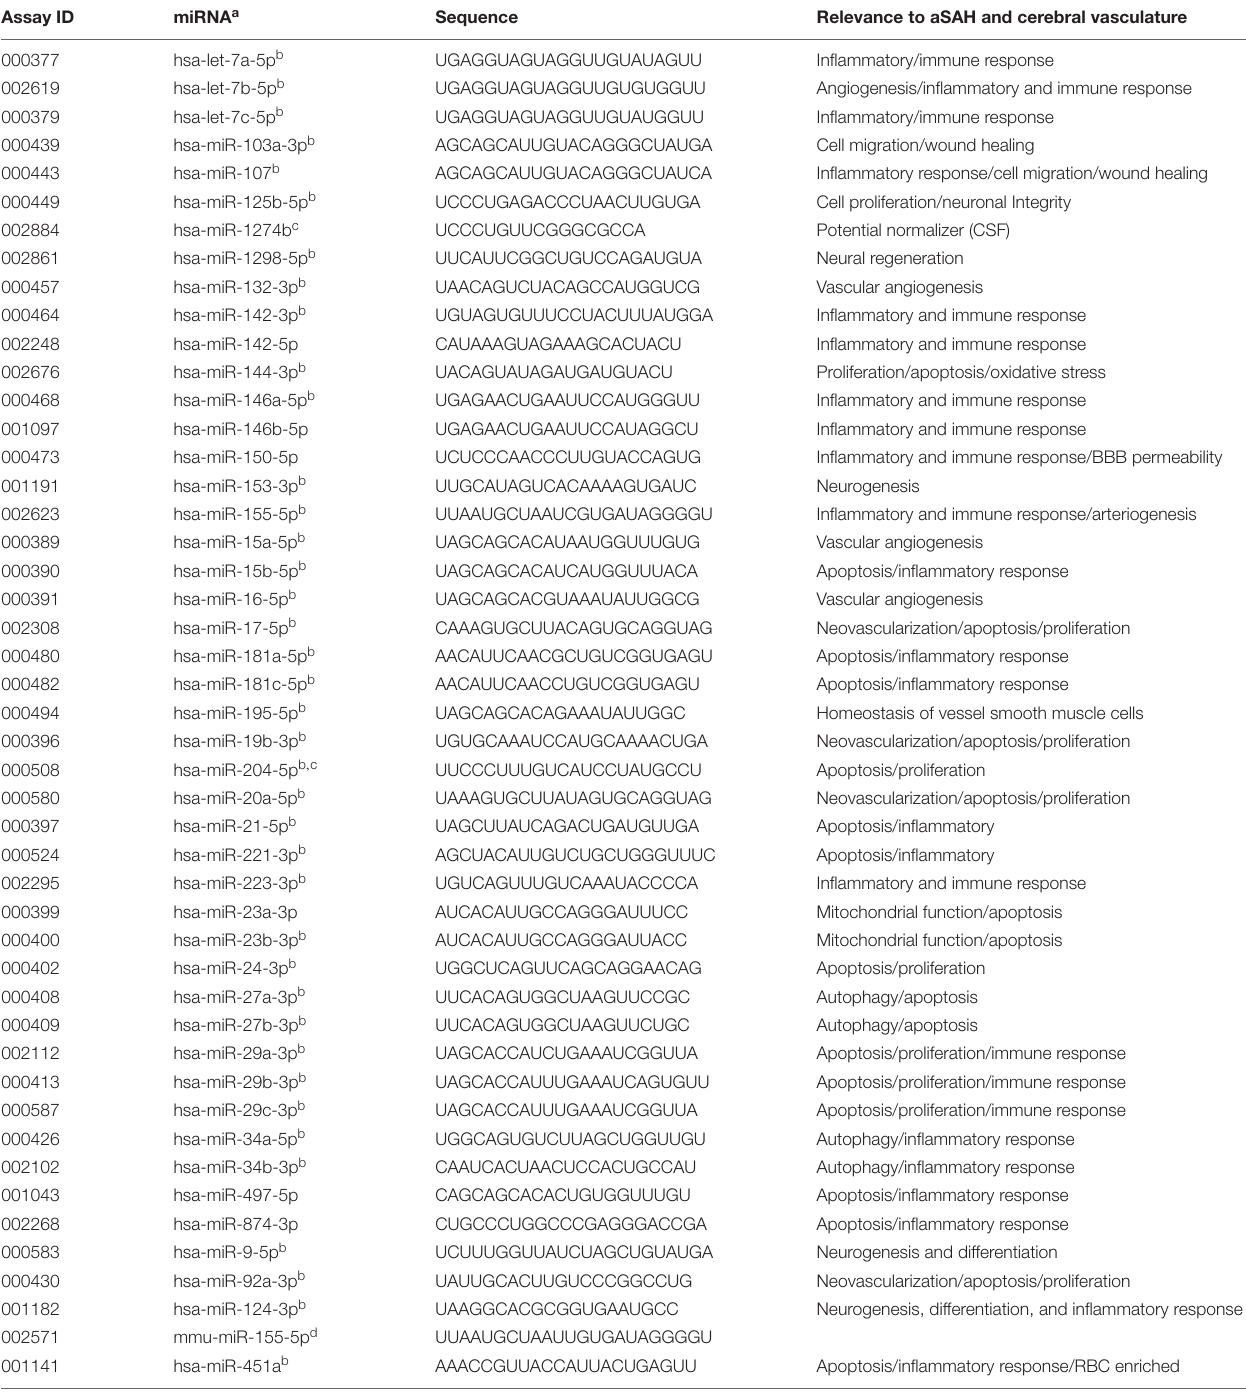
TABLE 2 | Selection of brain- and vasculature injury related miRNAs. Assay ID